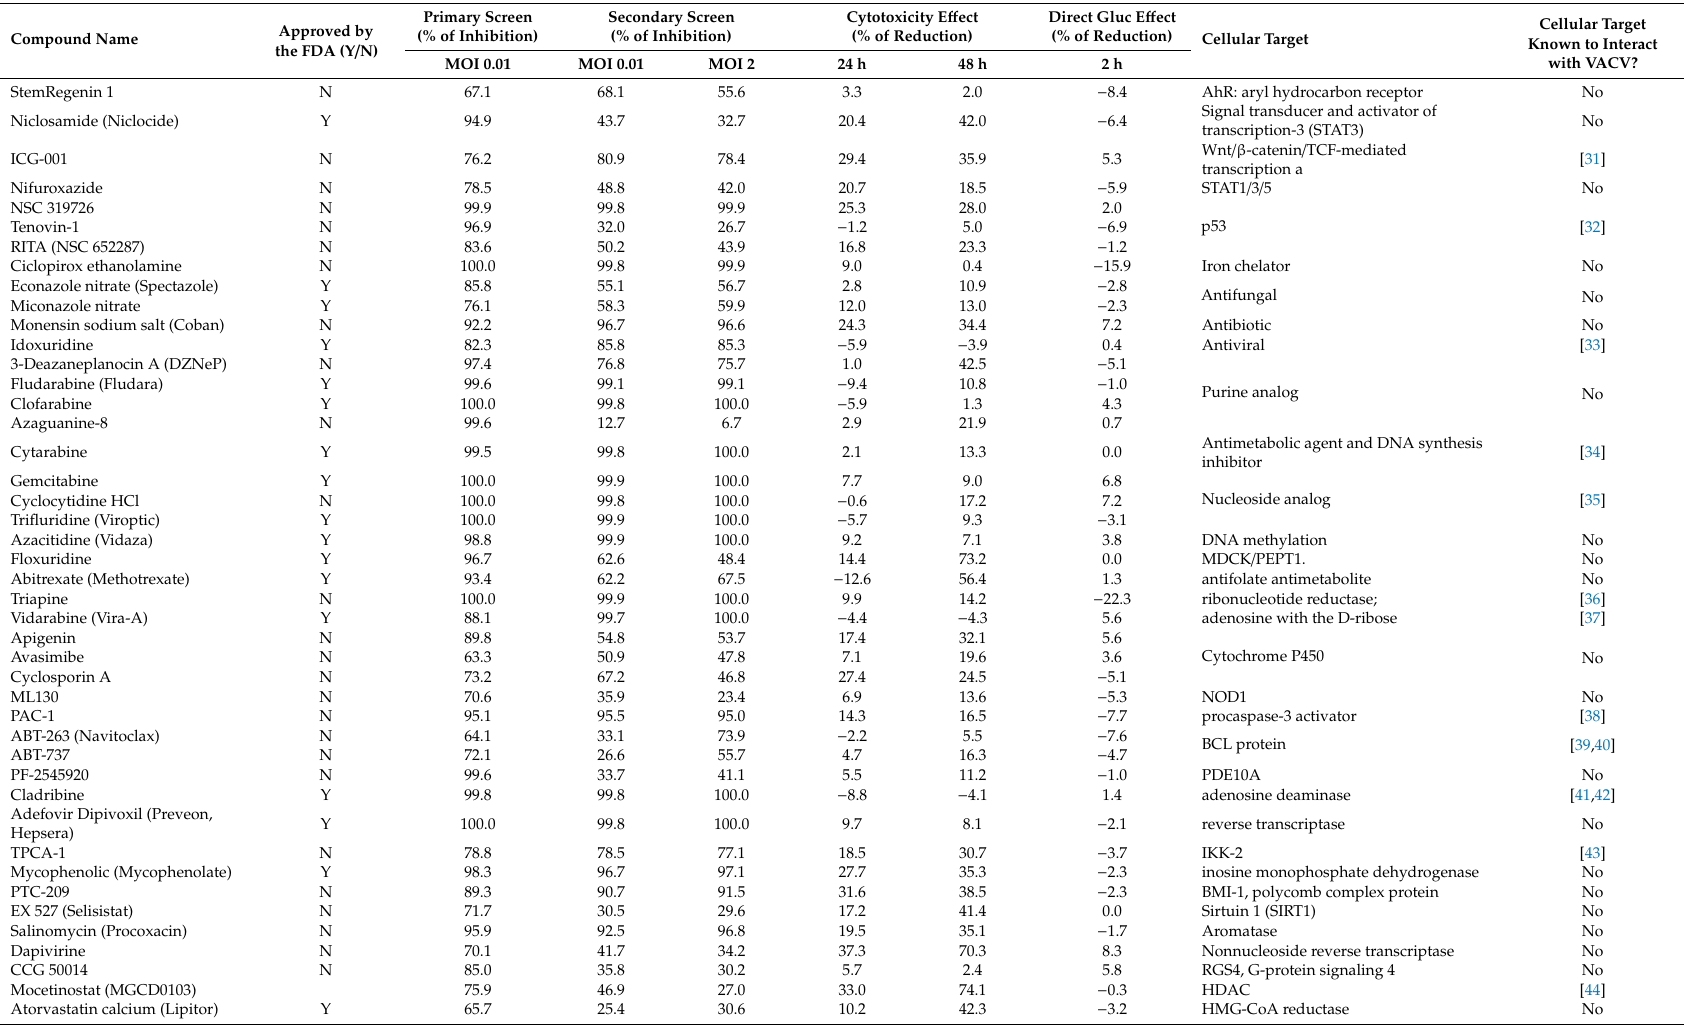
Table 1. Vaccinia virus (VACV) inhibitors identified after two-round of screens. FDA: Food and Drug